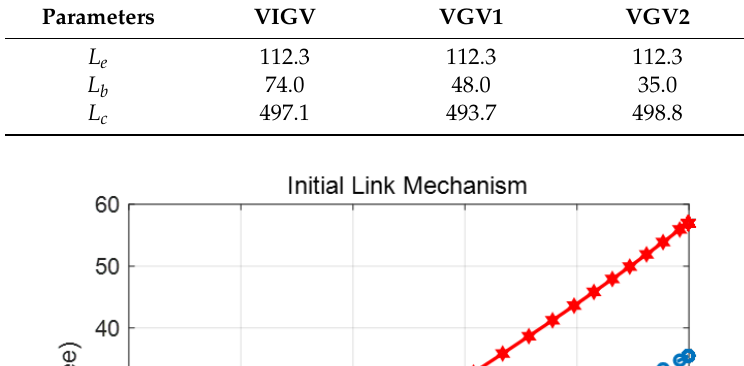
Figure 12. Scheduling results. ( a ) before link adjustment, ( b ) after link adjustment. Through the real engine application test, we verified the effectiveness of the control method using dual schedule curves on the VIGV stage. The vane angles were measured using the potentiometers on the stem of the vanes, and VIGV angles with respect to the actuator stroke were obtained, as shown in Figure 13. This hysteresis data was divided into two stroke-angle relations to represent the extension and compression cases of the actuator stroke. Inherent mechanical hysteresis